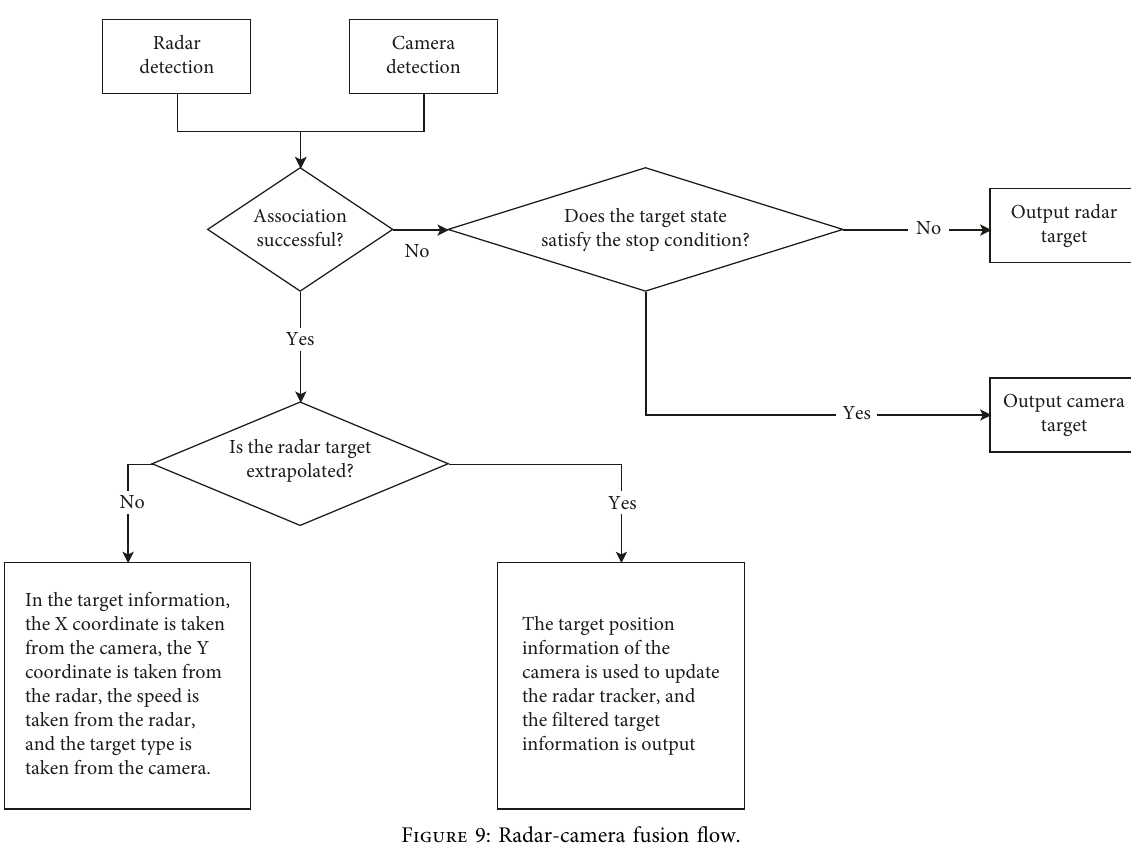
Figure 9: Radar-camera fusion